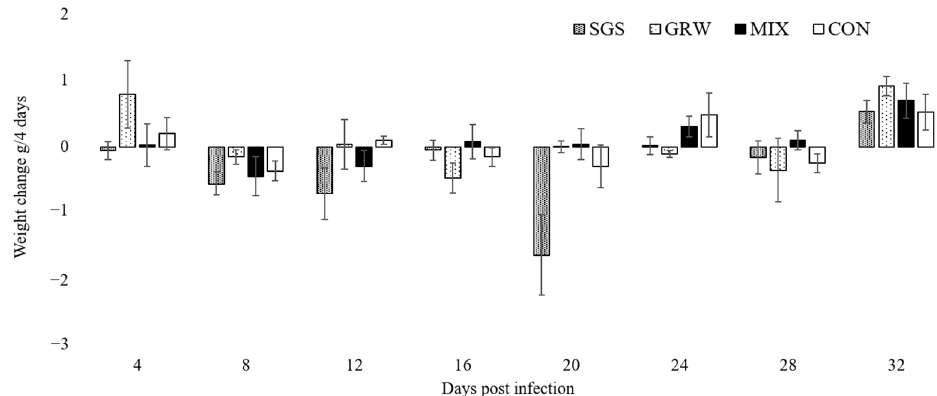
Figure 2. Body weight changes of experimentally infected and control canaries. SGS—birds infected with Plasmodium relictum (lineage pSGS1), GRW—birds infected with P. relictum (lineage pGRW11), MIX– birds co-infected with P. relictum pSGS1 and pGRW11, CON—control birds. Error bars represent standard errors.